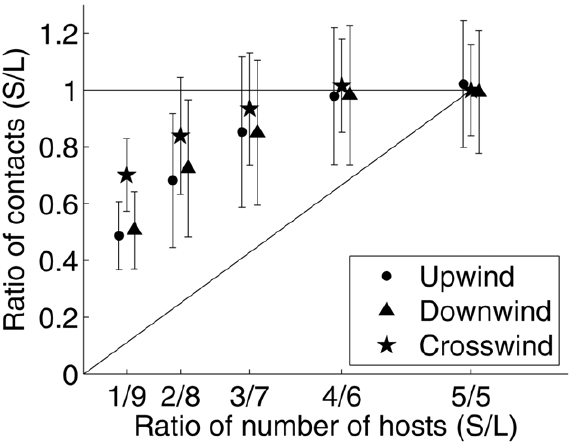
Figure 6. Ratio of contacts between a small and a large host group. Mean and standard deviation of the ratio of contacts in the small group to that in the large group (S/L) vs the ratio of group sizes. The line y ~ x denotes an equal per capita contact rate between groups, while the line y ~ 1 denotes an equal number of contacts at each group. The data corresponding to a given ratio of hosts have been separated slightly in the figure for visual purposes only.